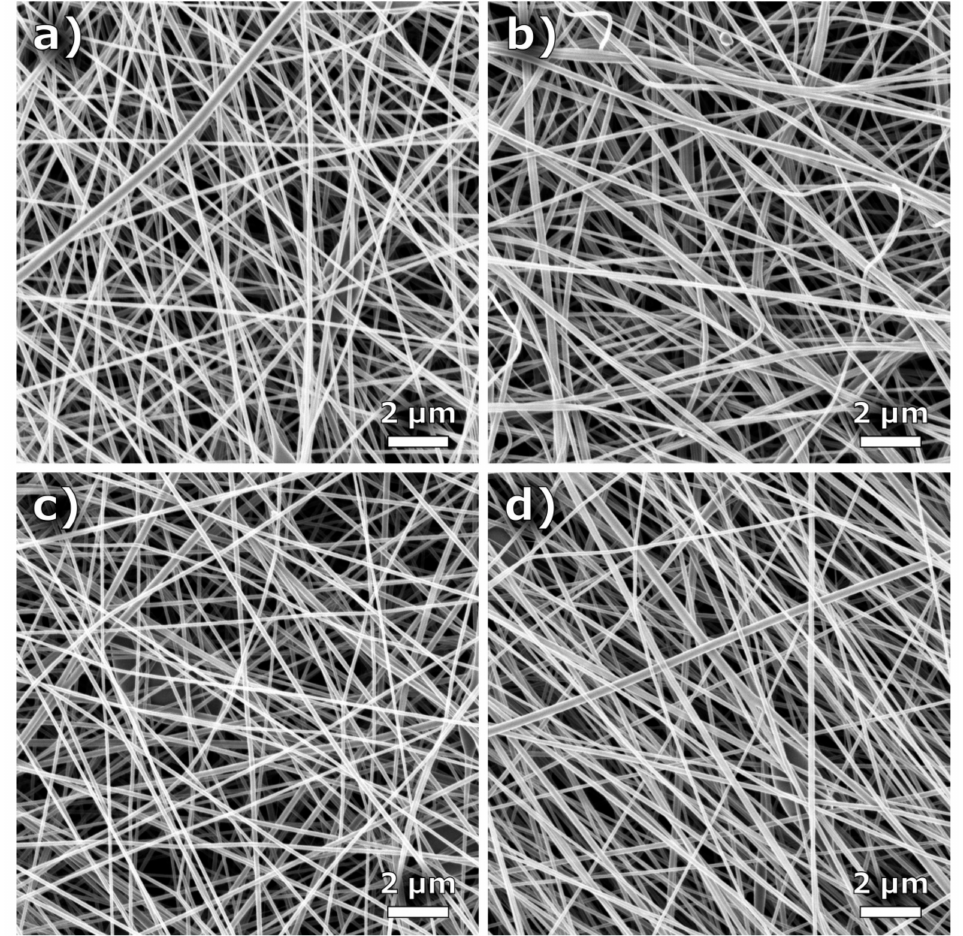
Figure 2. Helium ion microscope (HIM) images of the nanofibers on ( a ) silver–copper (Ag–Cu) flakes/graphite, ( b ) carbon black/poly(3,4-ethylenedioxythiophene) polystyrene sulfonate (PE- DOT:PSS), ( c ) TiO 2 /ITO and ( d ) TiO 2